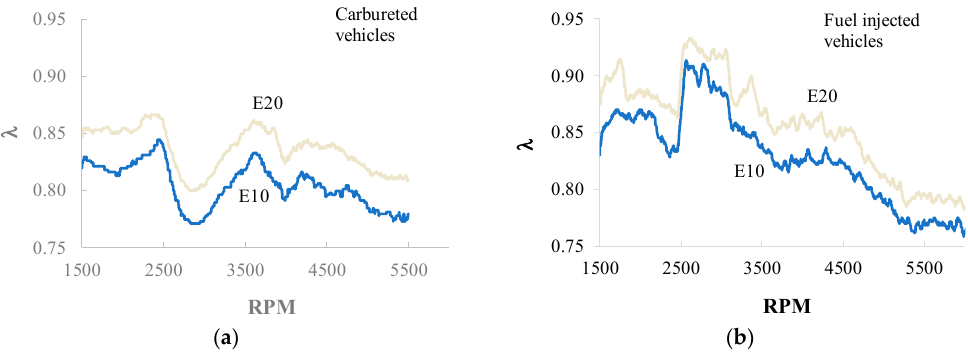
Figure 4. Effect of fuel changes in the operational conditions under which the vehicles work. λ vs. RPM obtained from ( a ) carbureted and ( b ) fuel-injected vehicles at full load .